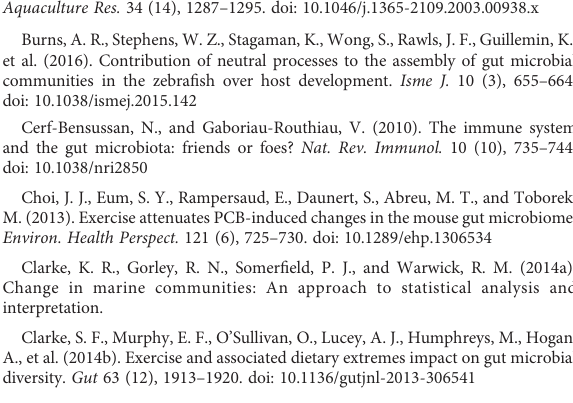
SUPPLEMENTARY FIGURE 1 Species accumulation curves of this hybrid species intestinal microbial samples. SUPPLEMENTARY FIGURE 2 Rarefaction curves of each sample derived from Illumina MiSeq